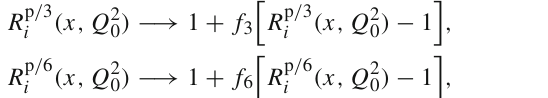
Fig. 1 Prototype of the EPPS21 fit functions R A green line corresponds to a 2 = 2, the dashed purple line to a 2 = 0, and the brown dotted-dashed line to a 2 = − 3